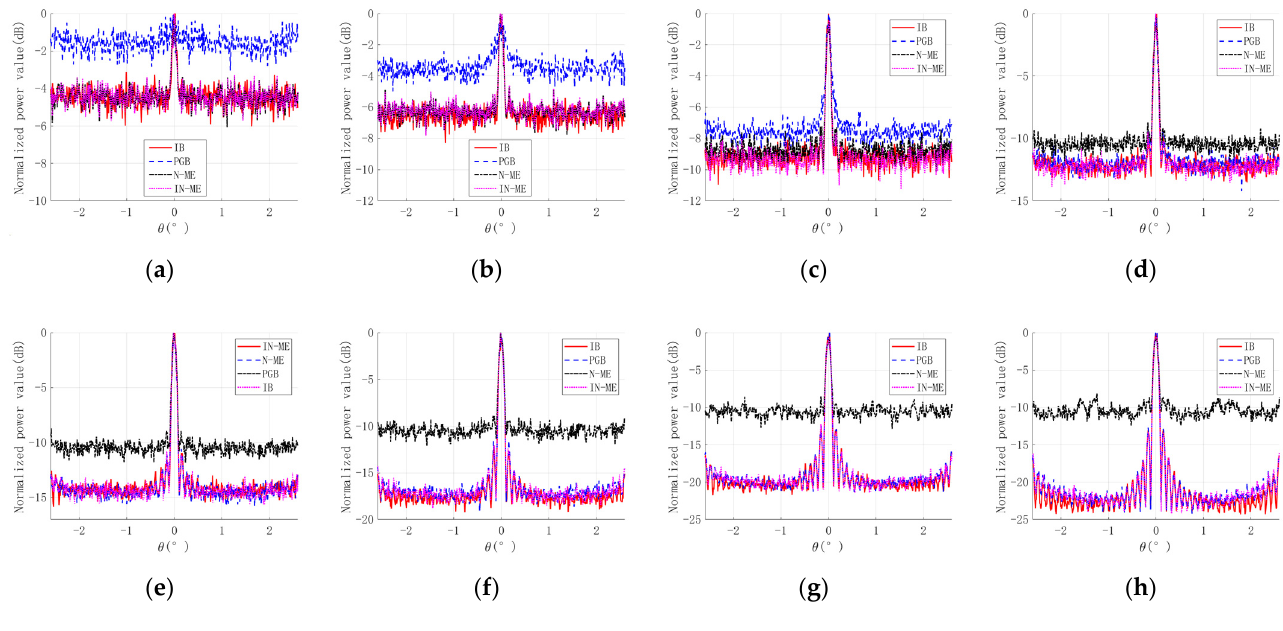
Figure 6. Beamforming contrast of two algorithms when SNR changes. ( a ) SNR = − 12 dB; ( b ) SNR = − 9 dB; ( c ) SNR = − 6 dB; ( d ) SNR = − 3 dB; ( e ) SNR = 0 dB; ( f ) SNR = 3 dB; ( g ) SNR = 6 dB; ( h ) SNR = 9 dB.